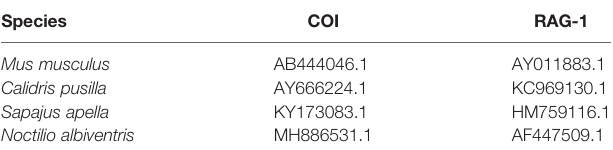
TABLE 2 | Molecular markers used for Cytochrome c oxidase subunit 1 (COI) and Recombination activating gene 1 (RAG-1) phylogenies with GenBank/The Barcode of Life Database accession numbers.